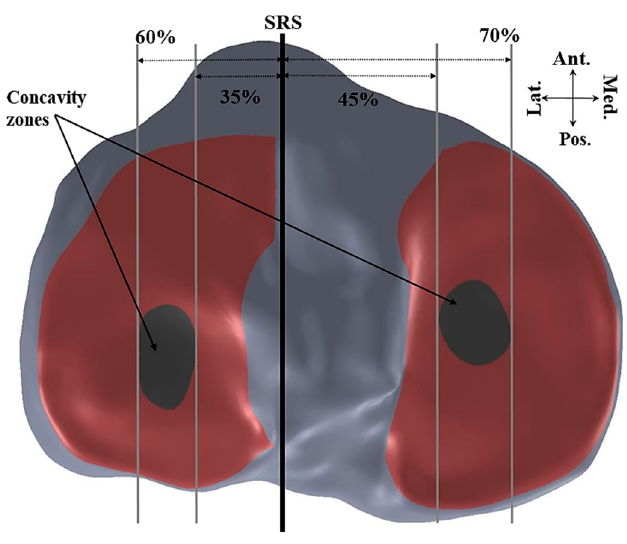
Figure 11. Definition of nodes placed on the concavity in a coronal slide (dotted line). Nodes C and D on both lateral and medial aspects are defined based on curvature analysis (coronal view).